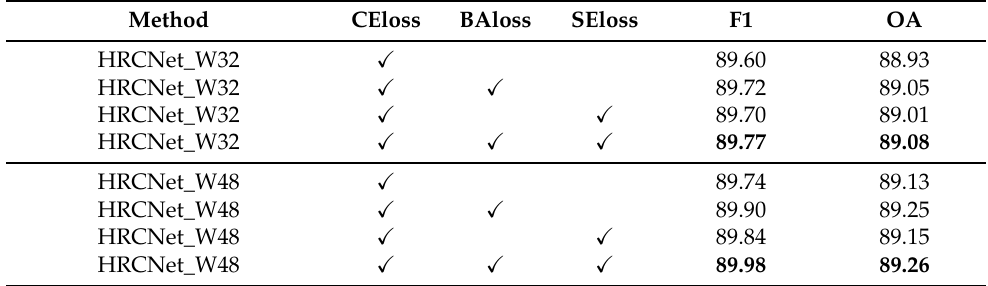
Table 11. The ablation experiments evaluated by F1 (%) and OA (%) about the multi-level loss functions.